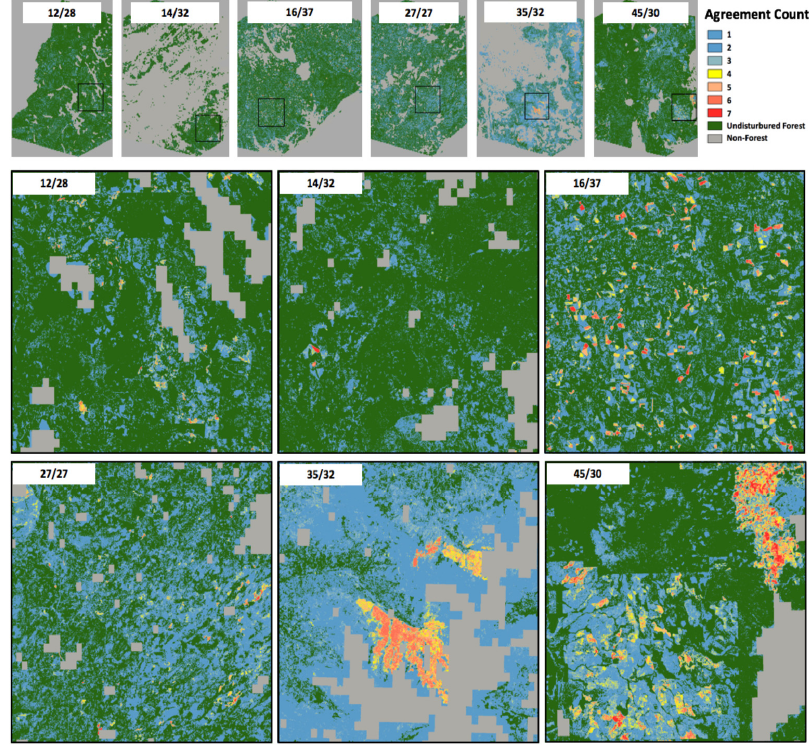
Figure 3. Example map sections for the year 2002 (middle and bottom rows), from each of the study scenes (top row), showing agreement among algorithm disturbance products. Boxes in top row show areas enlarged in middle and bottom